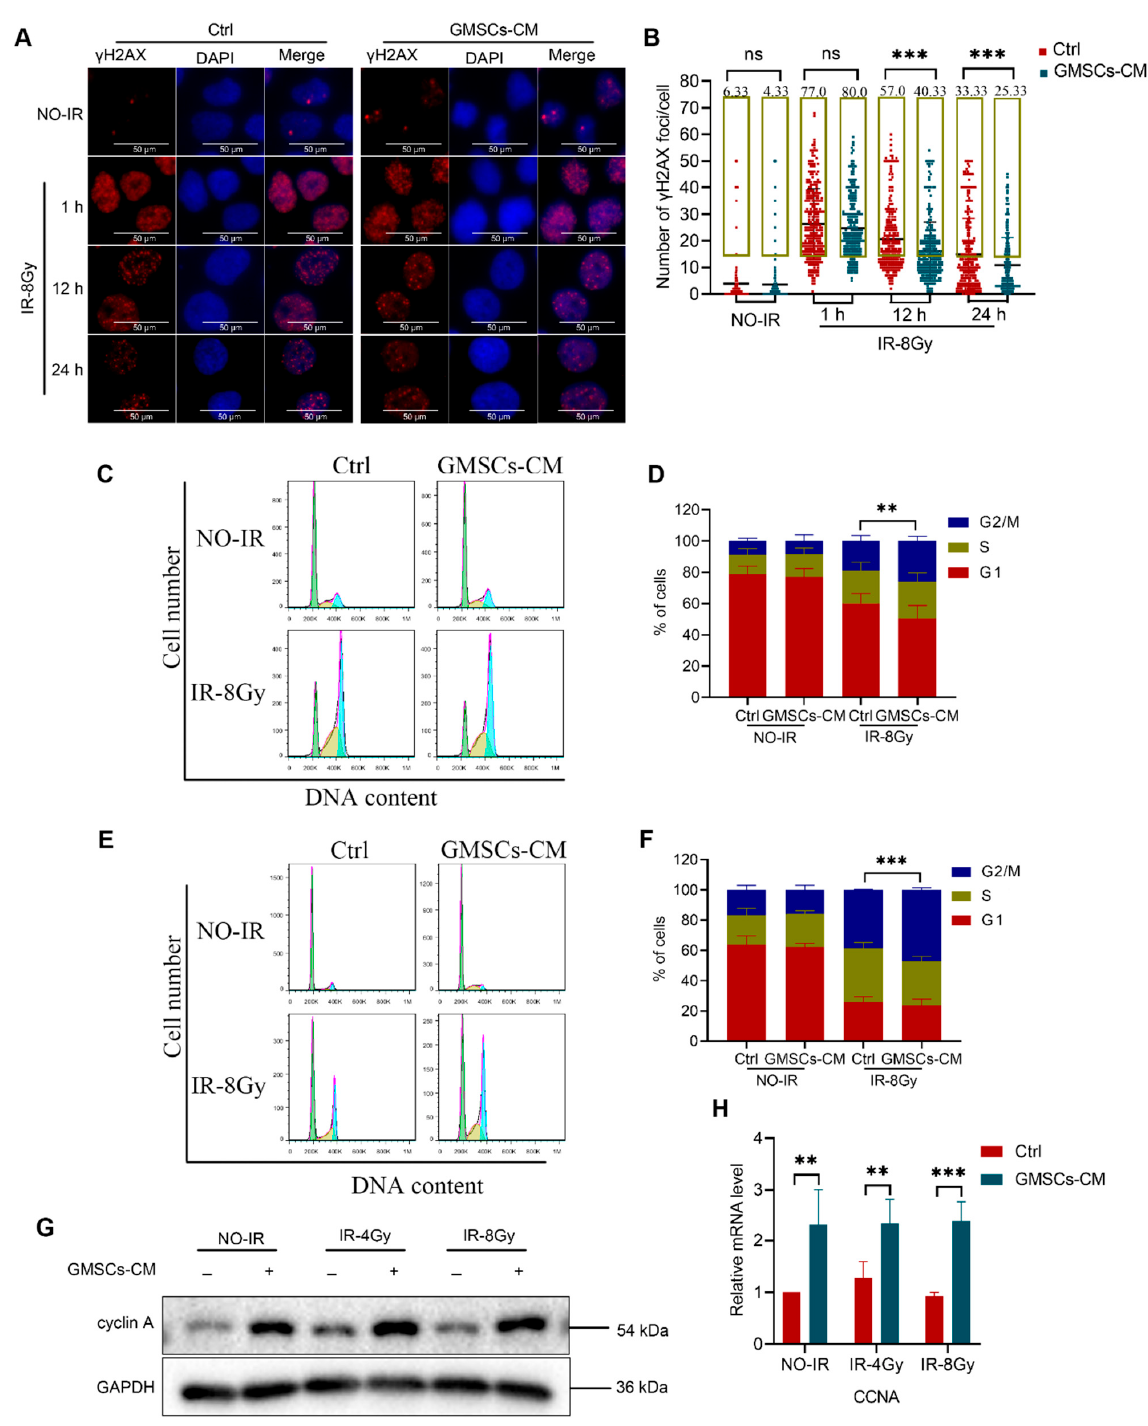
Figure 4. GMSCs enhance the ability of skin cells to repair DNA damage. ( A , B ) Skin cells exposed to 8 Gy. The γ H2AX foci were counted at 1, 12 and 24 h post-irradiation. ( C – F ) Flow cytometry histograms showing cell cycle progression of skin cells at 24 and 48 h post-irradiation ( C , E ). Proportions of cells in each phase of the cell cycle of skin cells at 24 and 48 h post-irradiation ( D , F ). ( G ) Western blot analysis of cyclin A protein expression in skin cells exposed to 8 Gy. ( H ) Measurement of the expression of the CCNA by qPCR analysis. Representative results from one of three independent experiments are shown. Data are expressed as the mean ± standard deviation. Statistical comparisons were made by a two-sample Student’s t -test, using the SPSS 25.0 software (IBM Corporation, Armonk, NY, USA). ns, not significant p > 0.05, ** p < 0.01 and *** p <